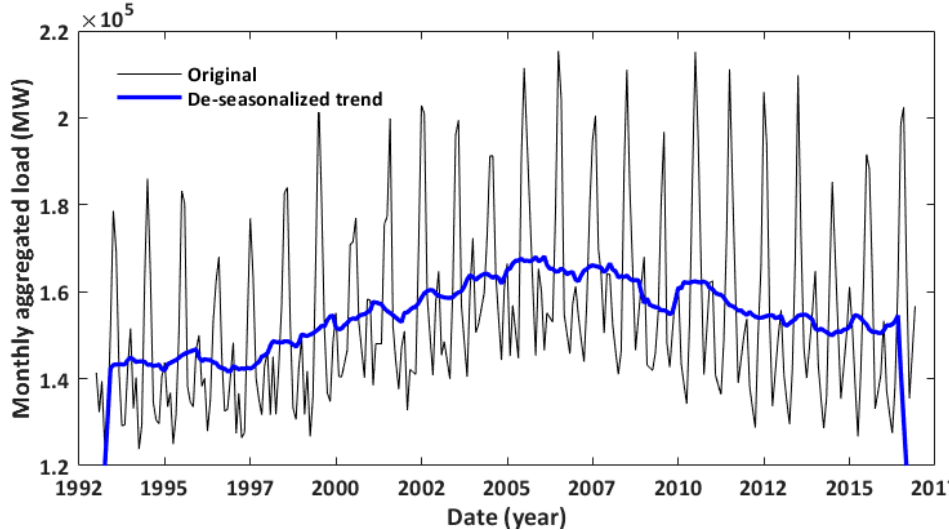
Figure 3. Monthly aggregated load data and de-seasonalized trend for years 1993–2016.